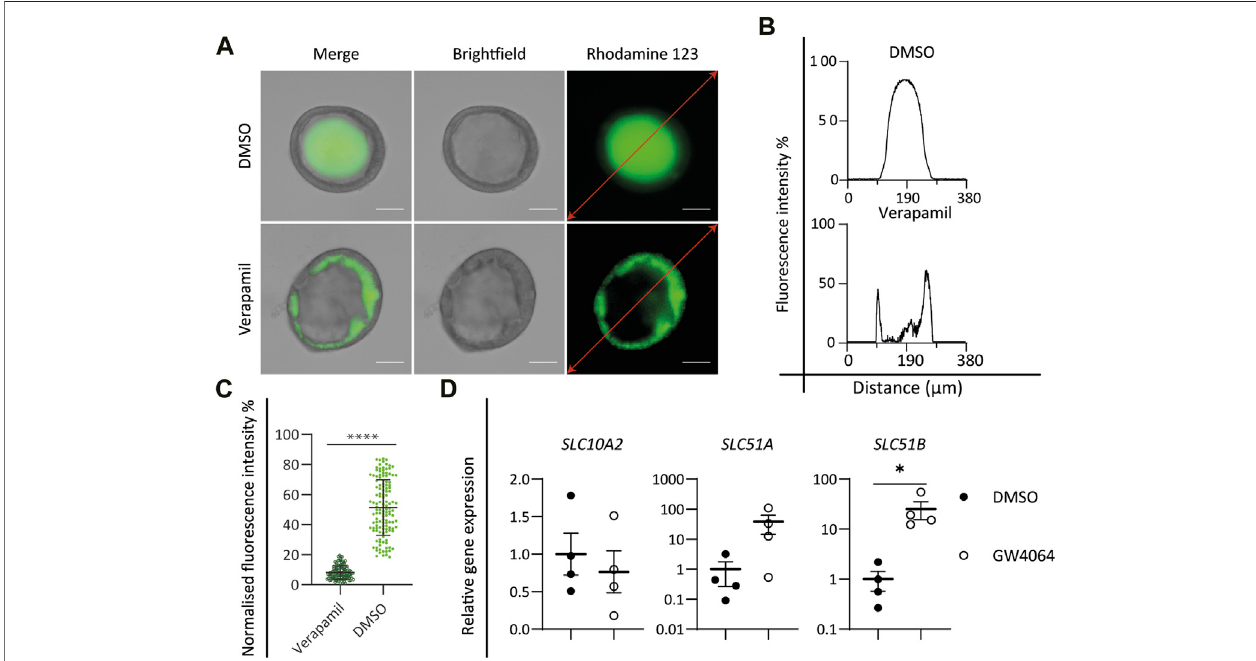
FIGURE 3 | Functional characterization of cholangiocyte-like cells (CLCs). (A – C) Rhodamine 123 transport assay. (A) Bright fi eld and fl uorescent images showing the P-glycoprotein transport function by active transport of rhodamine 123, DMSO as control, and verapamil as an inhibitor of P-glycoprotein function. Scale bar = 50 μ m. Graphs depicting the fl uorescence intensity alongthe red lines in the images in (A) . (C) Mean intraluminal fl uorescence intensity normalized to background levels forcysticcholangiocyte.Dataareshownasmean±SDforeachgroup.Statisticaldifferencesbetweengroupswereanalyzedusingthetwo-tailedMann – WhitneyU test; verapamil, N = 127; DMSO, N = 132; **** p < 0.0001. (D) FXR assay. Gene expression analysis showing the activation of FXR signaling downstream target genes, SLC10A2,SLC51A ,and SLC51B inDMSOversustheFXRagonist(GW4064)-treatedgroup. N =4independentdonorsforeachgroup.Dataareshownasmean±SEM of four independent experiments for each group. Statistical differences between groups were determined using the paired t -test; DMSO, N = 4; GW4064, N = 4; * p <